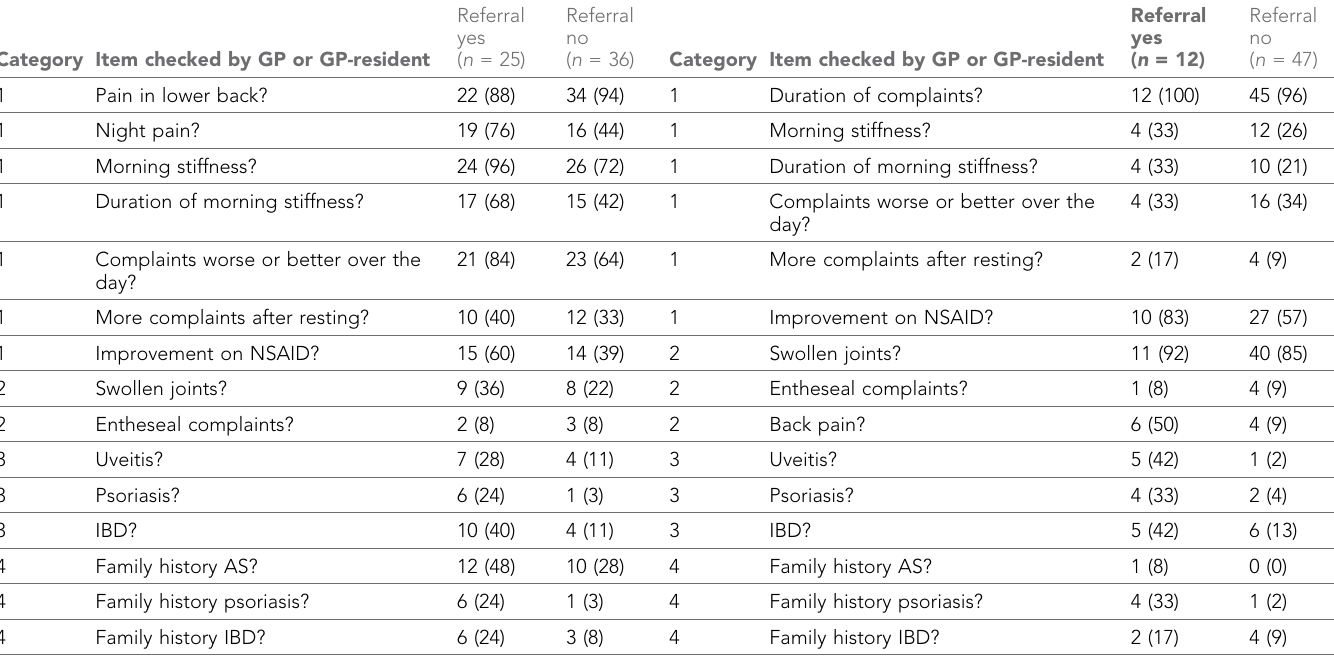
Table 3. Pattern of history taking in round 2: referral versus no referral Axial spondyloarthritis Peripheral spondyloarthritis